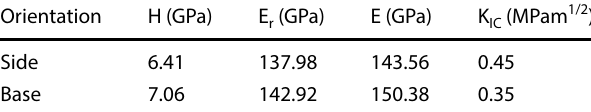
Fig. 19 Values for: a Compressive strength b Vickers hardness [108]